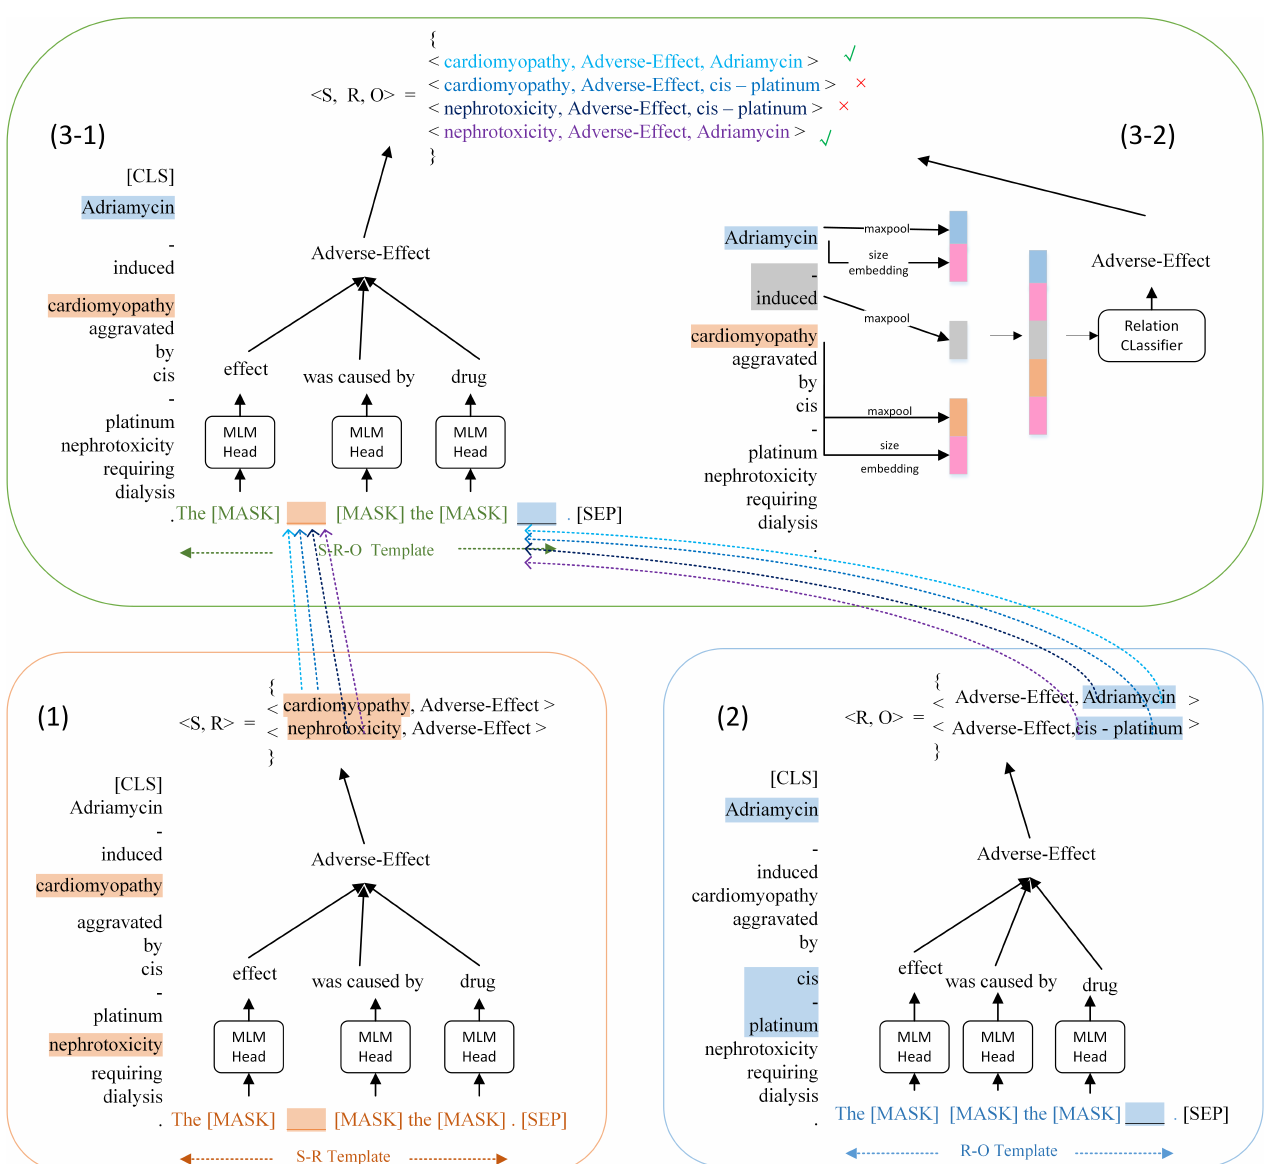
Figure 2. Our framework SSPC consists of three parts, (cid:104) S , R (cid:105) Extraction ( 1 ), (cid:104) R , O (cid:105) Extraction ( 2 ), and (cid:104) S , R , O (cid:105) Classification( ( 3-1 ) and ( 3-2 )